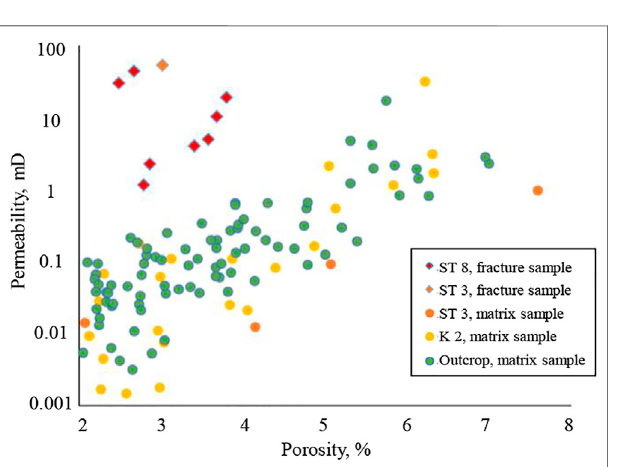
Frontiers in Energy Research |